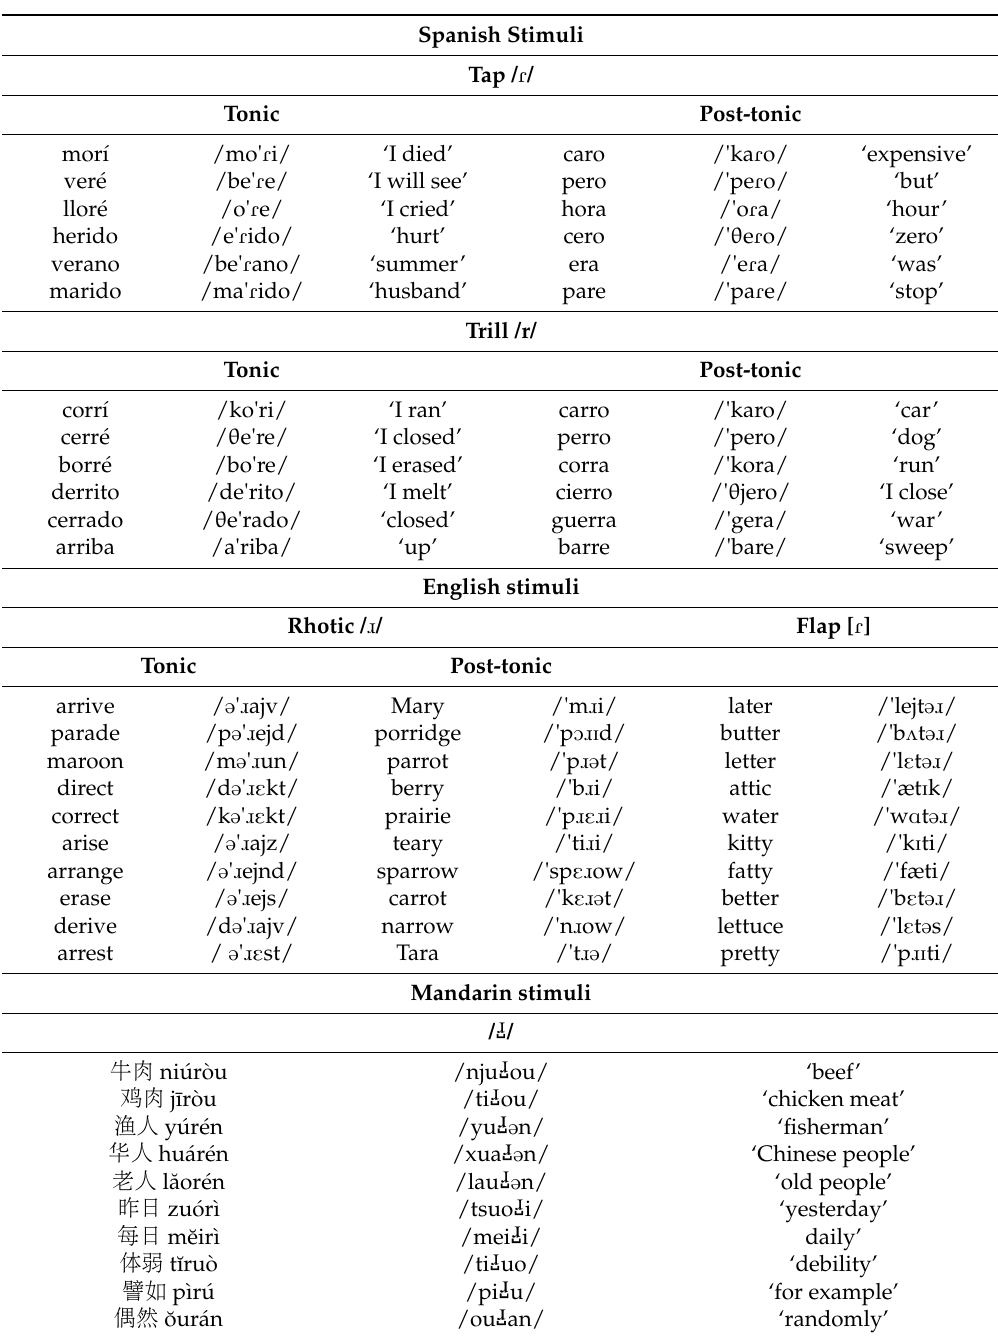
Table A2. L1 Mandarin, L2 English, and L3 Spanish target